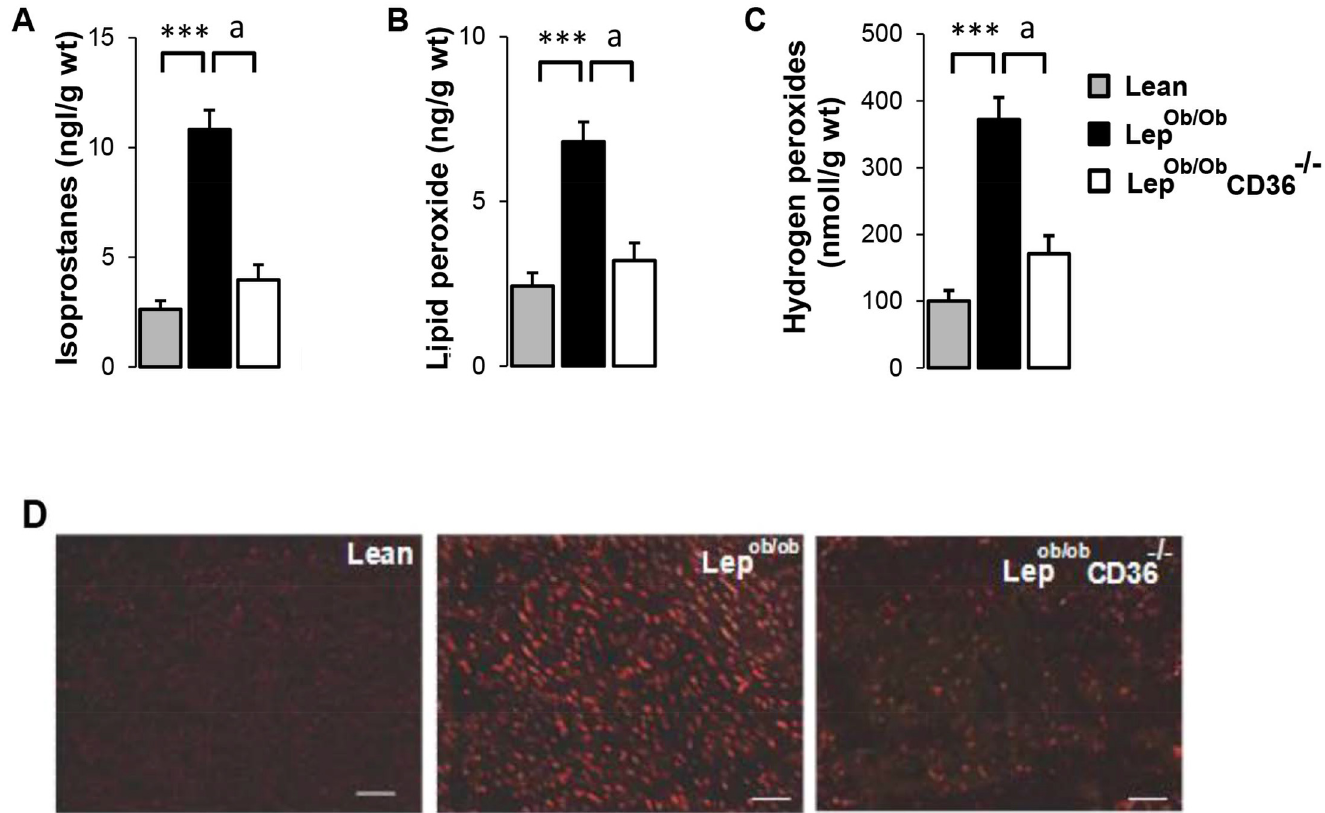
Fig 6. Effects of CD36 expression on cardiac oxidative stress markers. Contents of Isoprostanes (A) and lipid peroxides (B) were measured in heart homogenates using gas chromatographic/mass spectrometry and enzymatic kit, respectively. Hydrogen peroxides (C) were evaluated using Amplex Red method. Data are means ± SEM of duplicates from an n = 6 per group. Differences between Lep ob/ob and Lean mice are indicated with asterisks ** p < 0.01, and differences between Lep ob/ob CD36 -/- and Lep ob/ob mice are indicated with alphabetic letters a p < 0.01 and b p < 0.05.